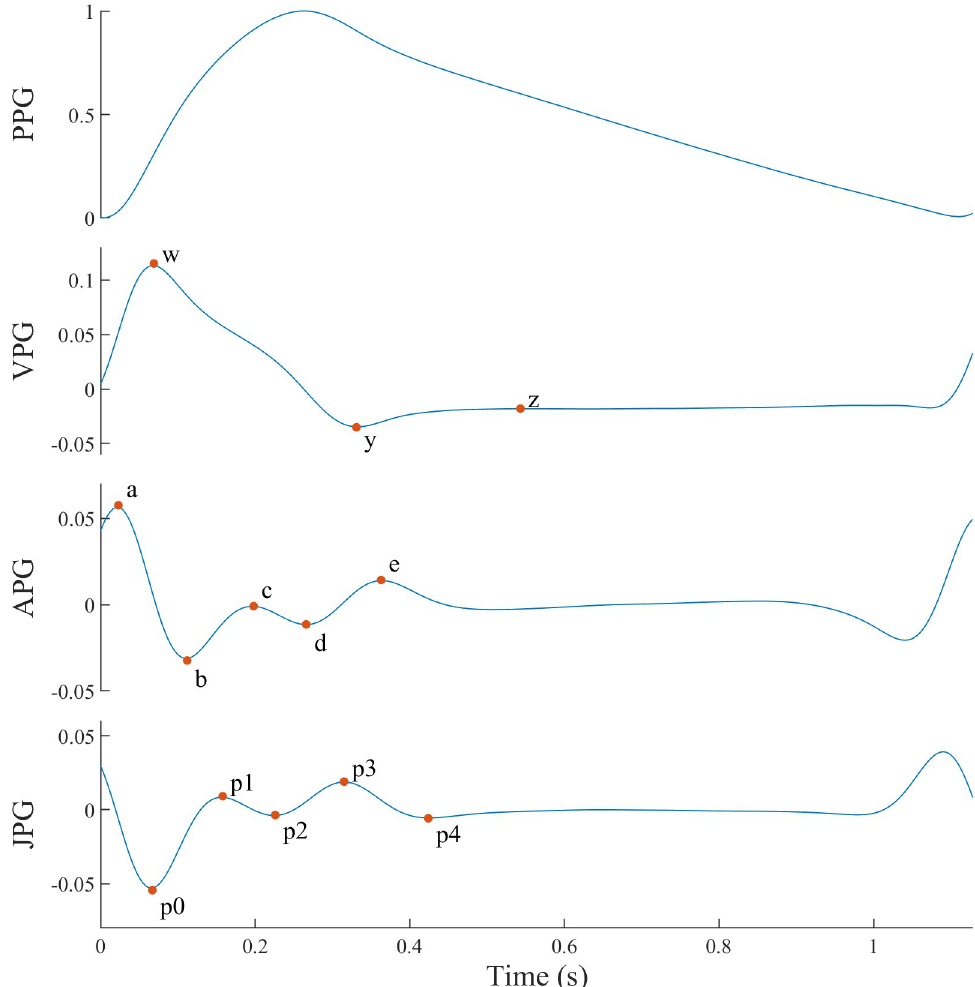
Fig 2. PPG derivatives with characteristic points. Illustration of a typical PPG waveform with its 1 st , 2 nd and 3 rd derivatives, which are respectively known as velocity plethysmogram (VPG), acceleration plethysmogram (APG) and Jerk plethysmogram (JPG). The fiducial points of each derivative are also